Question: Name the type of graph shown.
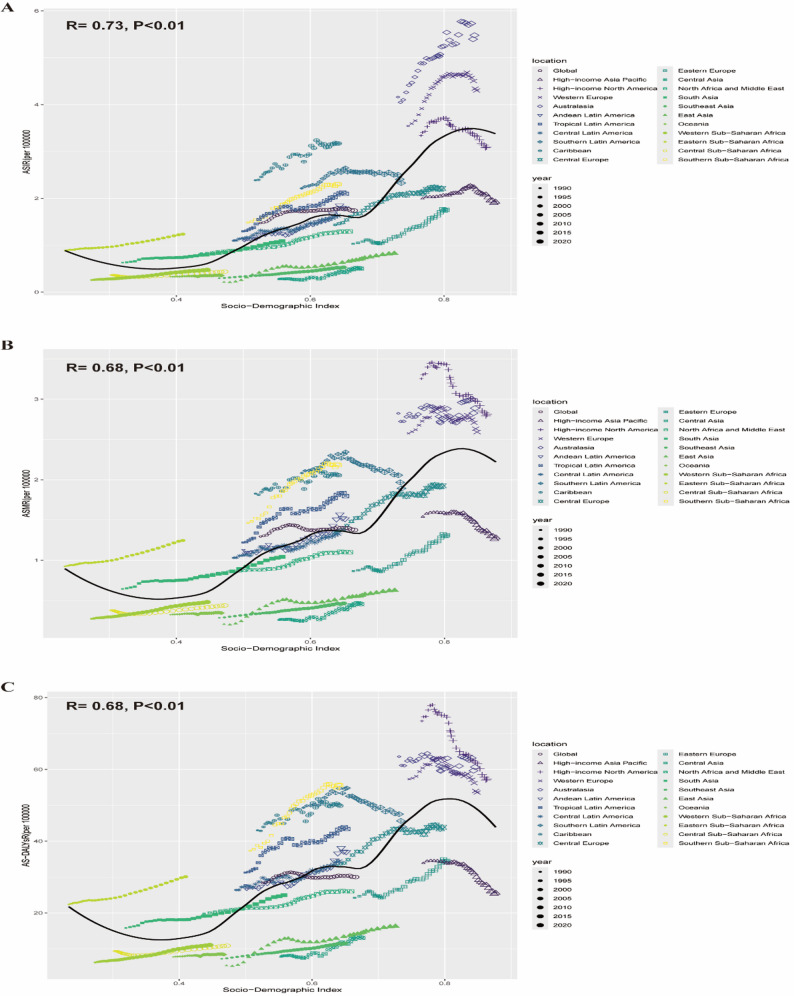
Answer: line